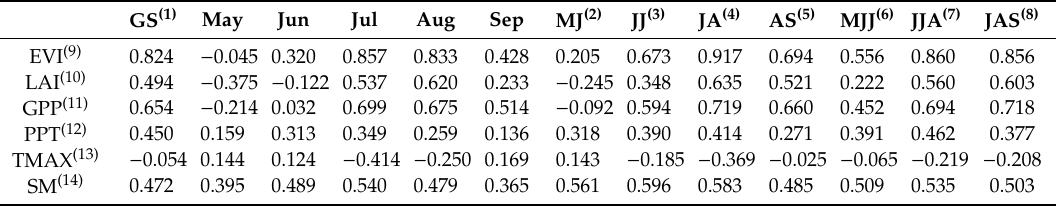
Table 4. Correlation coe ffi cients between the selected variables and corn yields according to combinations of months, 2006–2015.